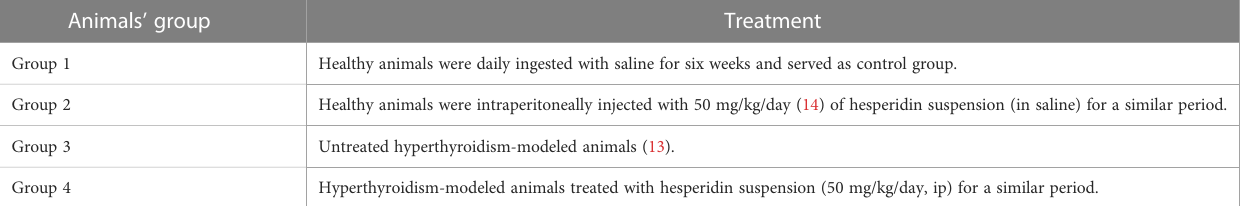
TABLE 1 Experimental